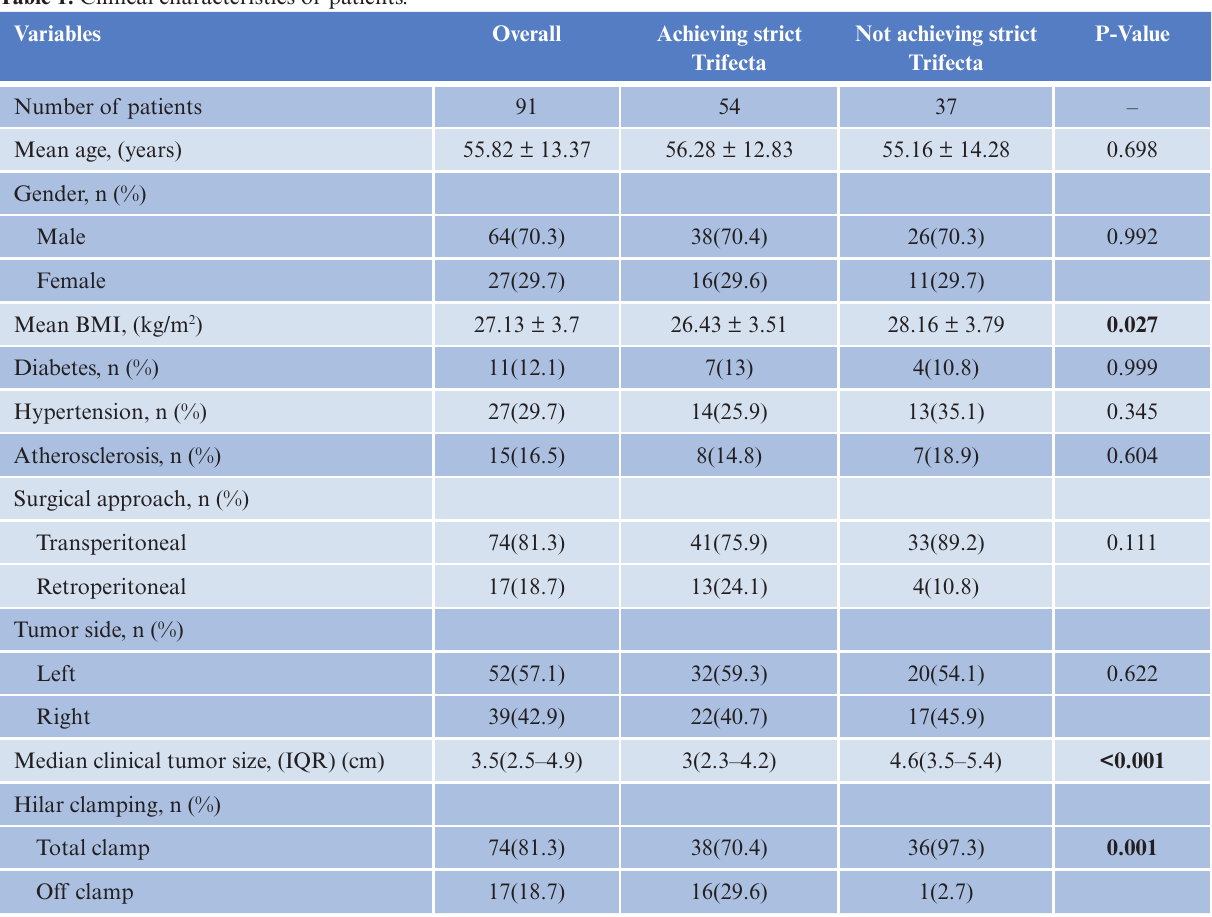
Table 1: Clinical characteristics of patients. Variables